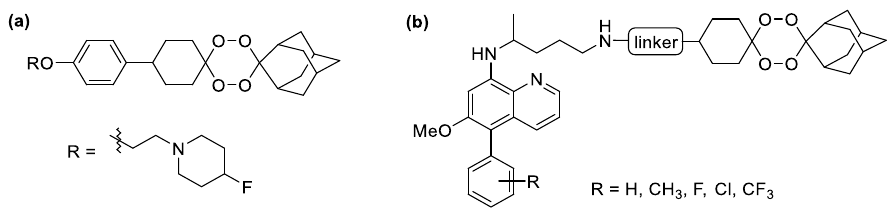
Figure 2. ( a ) E209; ( b ) tetraoxane-5-phenyl primaquine hybrids.